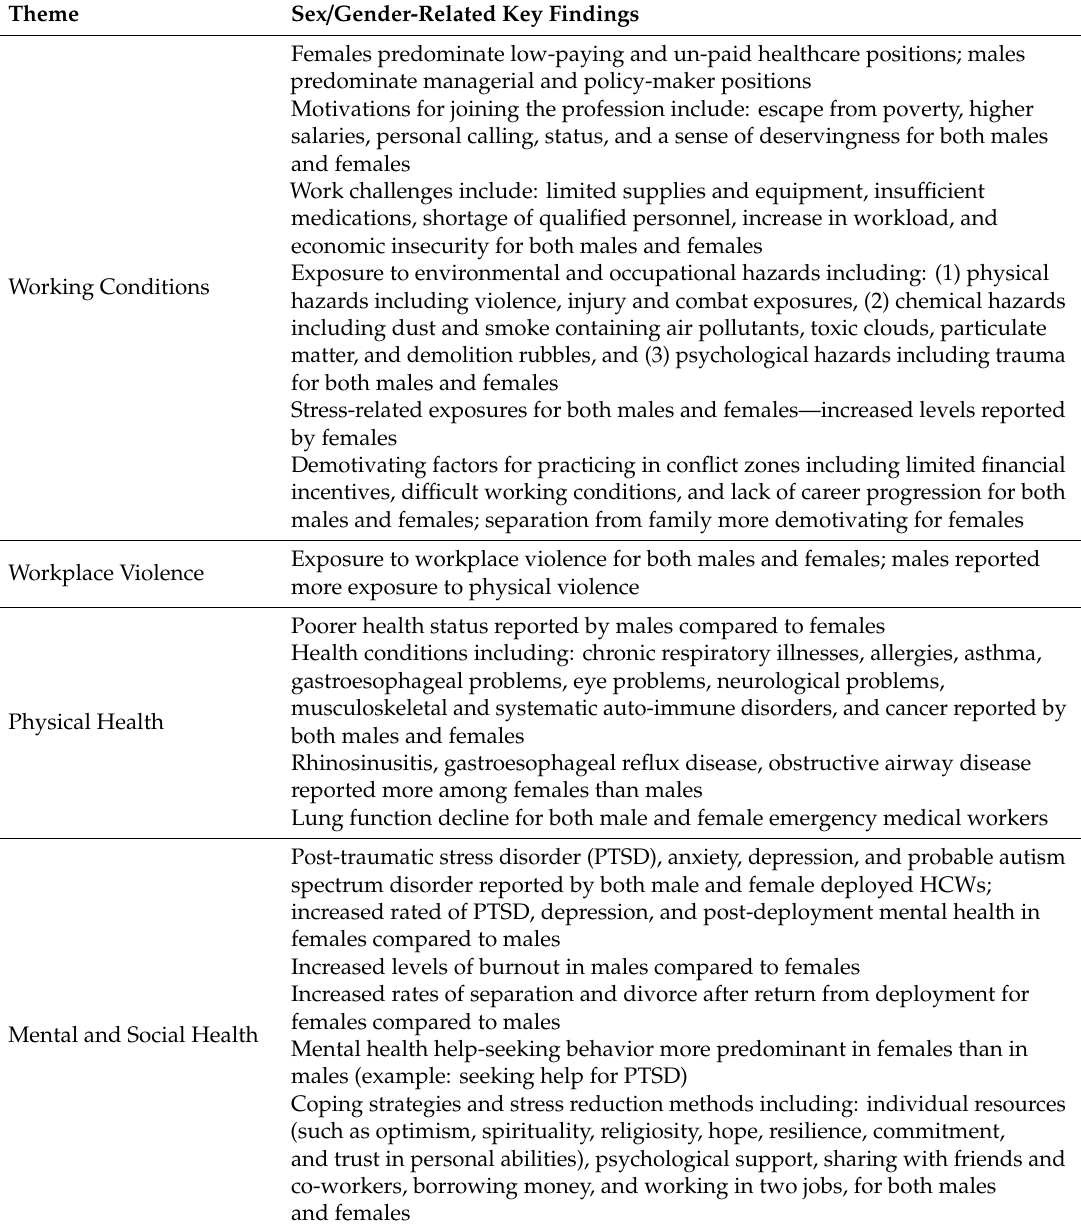
Table 3. Sex / gender-related key findings of included articles by